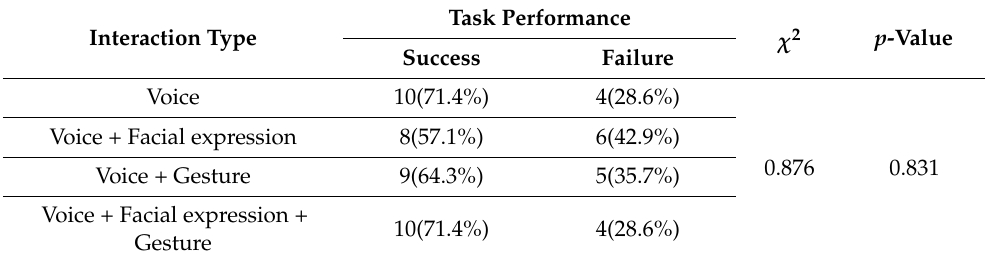
Table 7. Results of the cross-tabulation analysis on success rate according to interaction type.